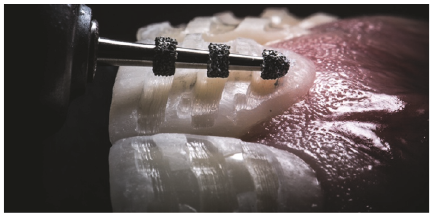
Figure 2: Digital smile design (DSD). Planning of the anterior teeth proportions for the wax-up.